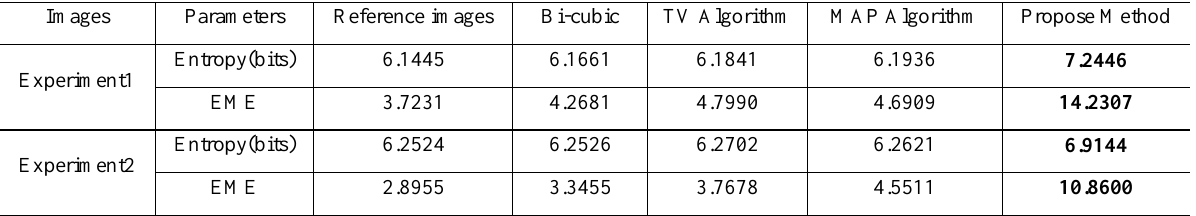
Tab.1 Experimental results index